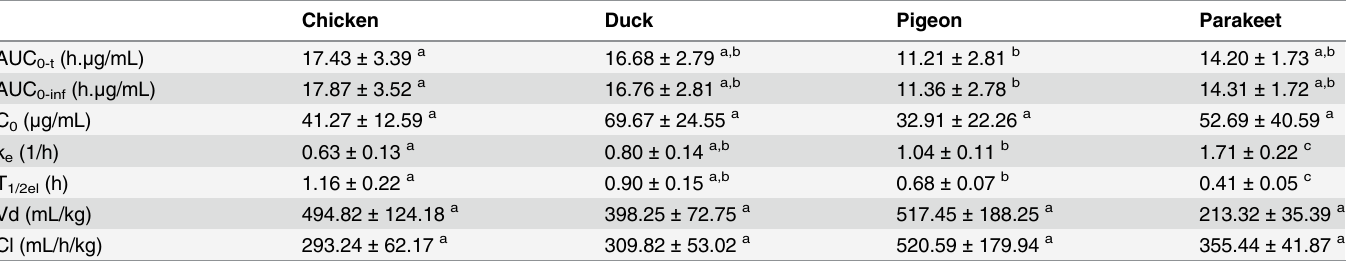
Table 1. Main pharmacokinetic parameters of free carboplatin after intravenous administration (5 mg/kg BW) to chickens, ducks, pigeons and parakeets. Chicken Duck Pigeon